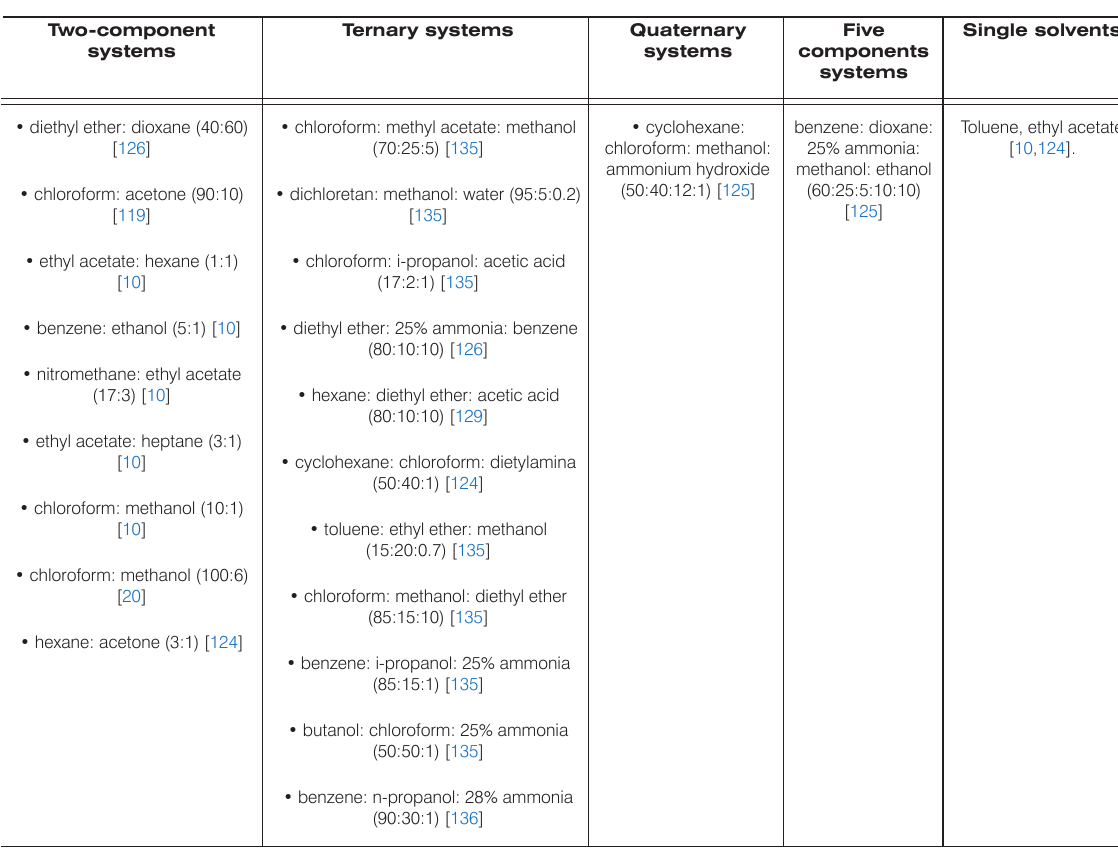
Table 1. Solvents mixtures composition for mobile phase separation in TLC. Solvents mixtures composition for mobile phase